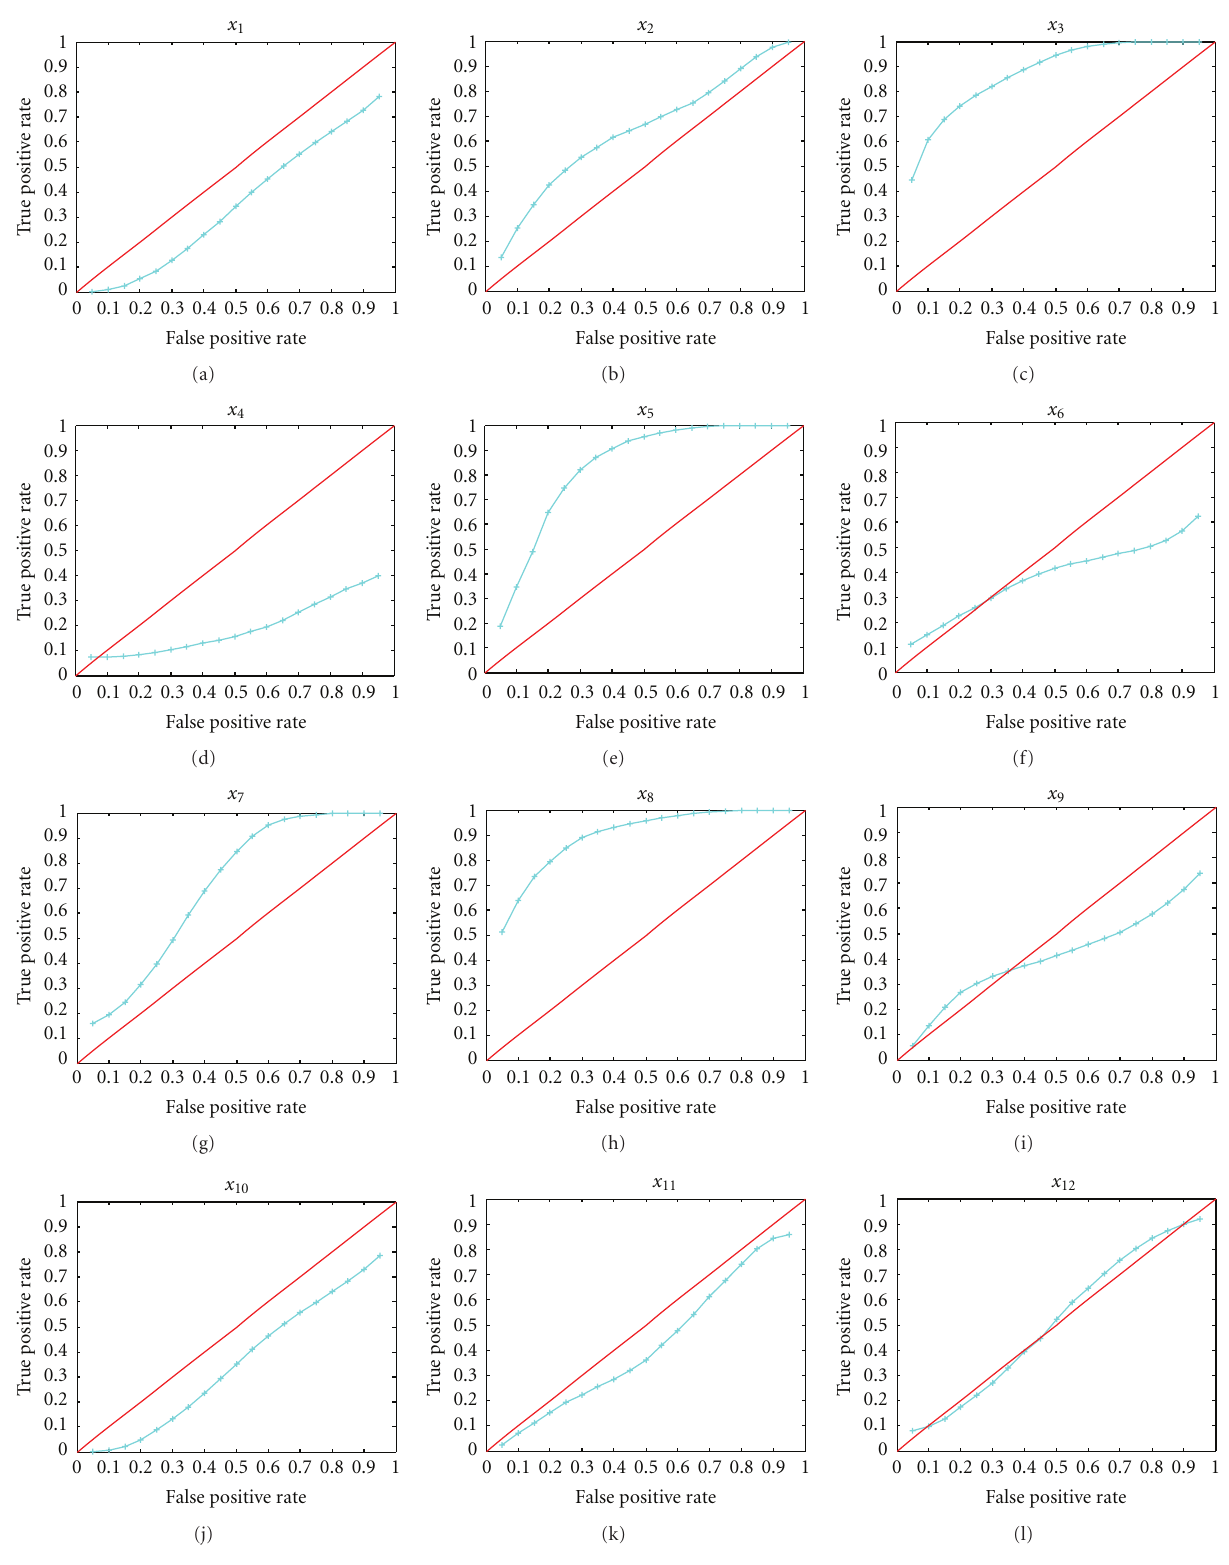
Figure 3: BB estimates of ROC curves for diagnostic covariates for